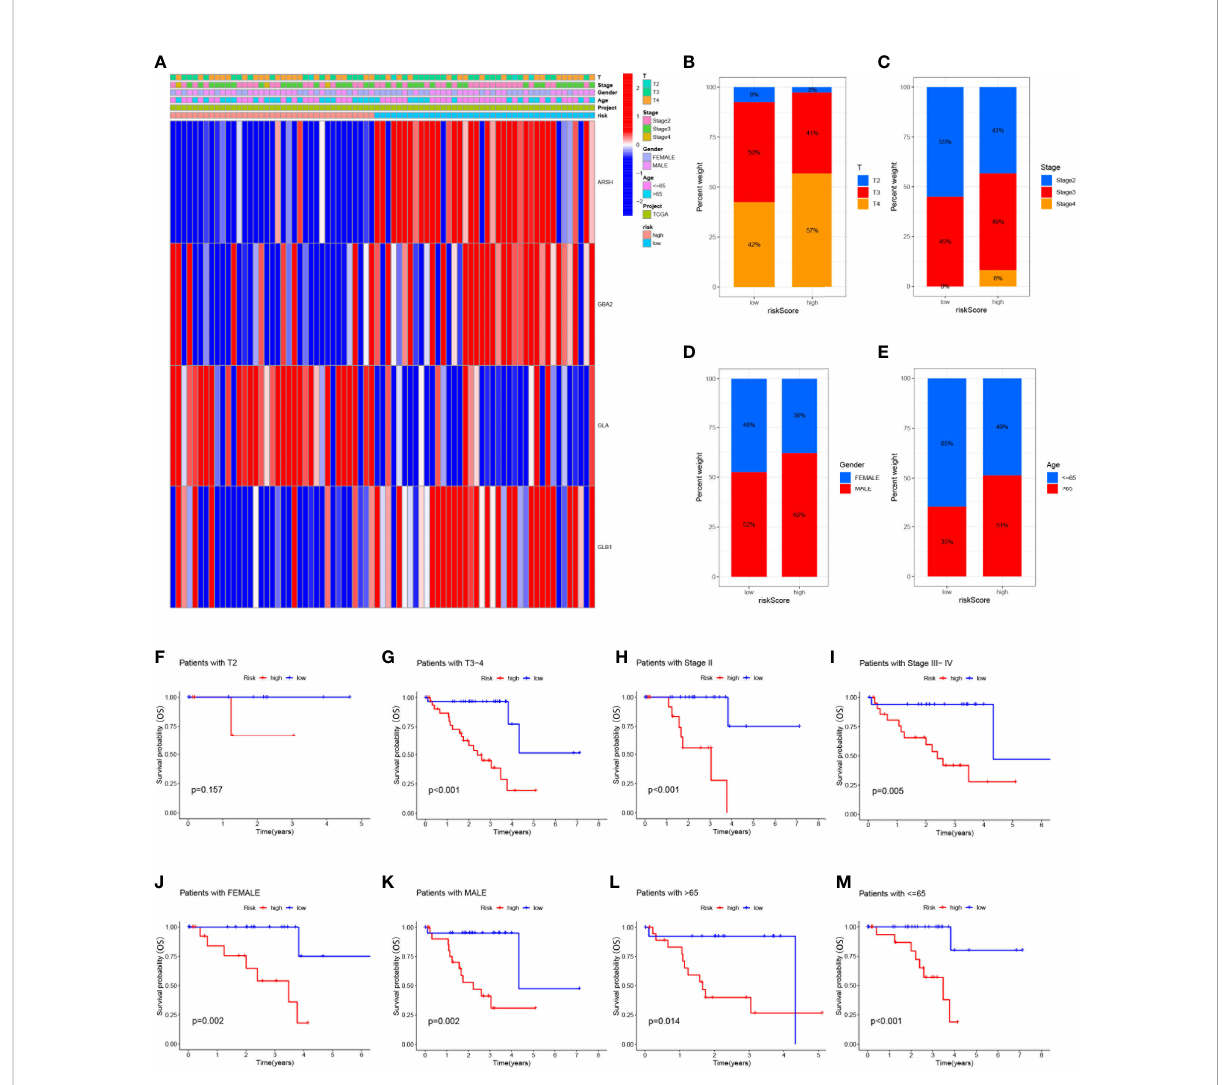
FIGURE 4 Clinical correlation and survival analysis of SMGs in patients with UVM (A) heatmap showing the associations between the high-risk and low-risk score of patients with UVM and UVM related clinical characteristics in the dataset from TCGA. (B-E) The percentage Stacked histogram of clinical characteristics. The risk score based on 4-SMGs signature is a valuable marker for poor prognosis in various subgroups divided by clinicopathological characteristics. The SMGs could distinguish high-risk patients in a variety of subgroups divided by clinicopathological characteristics including (F, G) T stage, (H, I) clinical stage, (J, K) gender and (L, M)